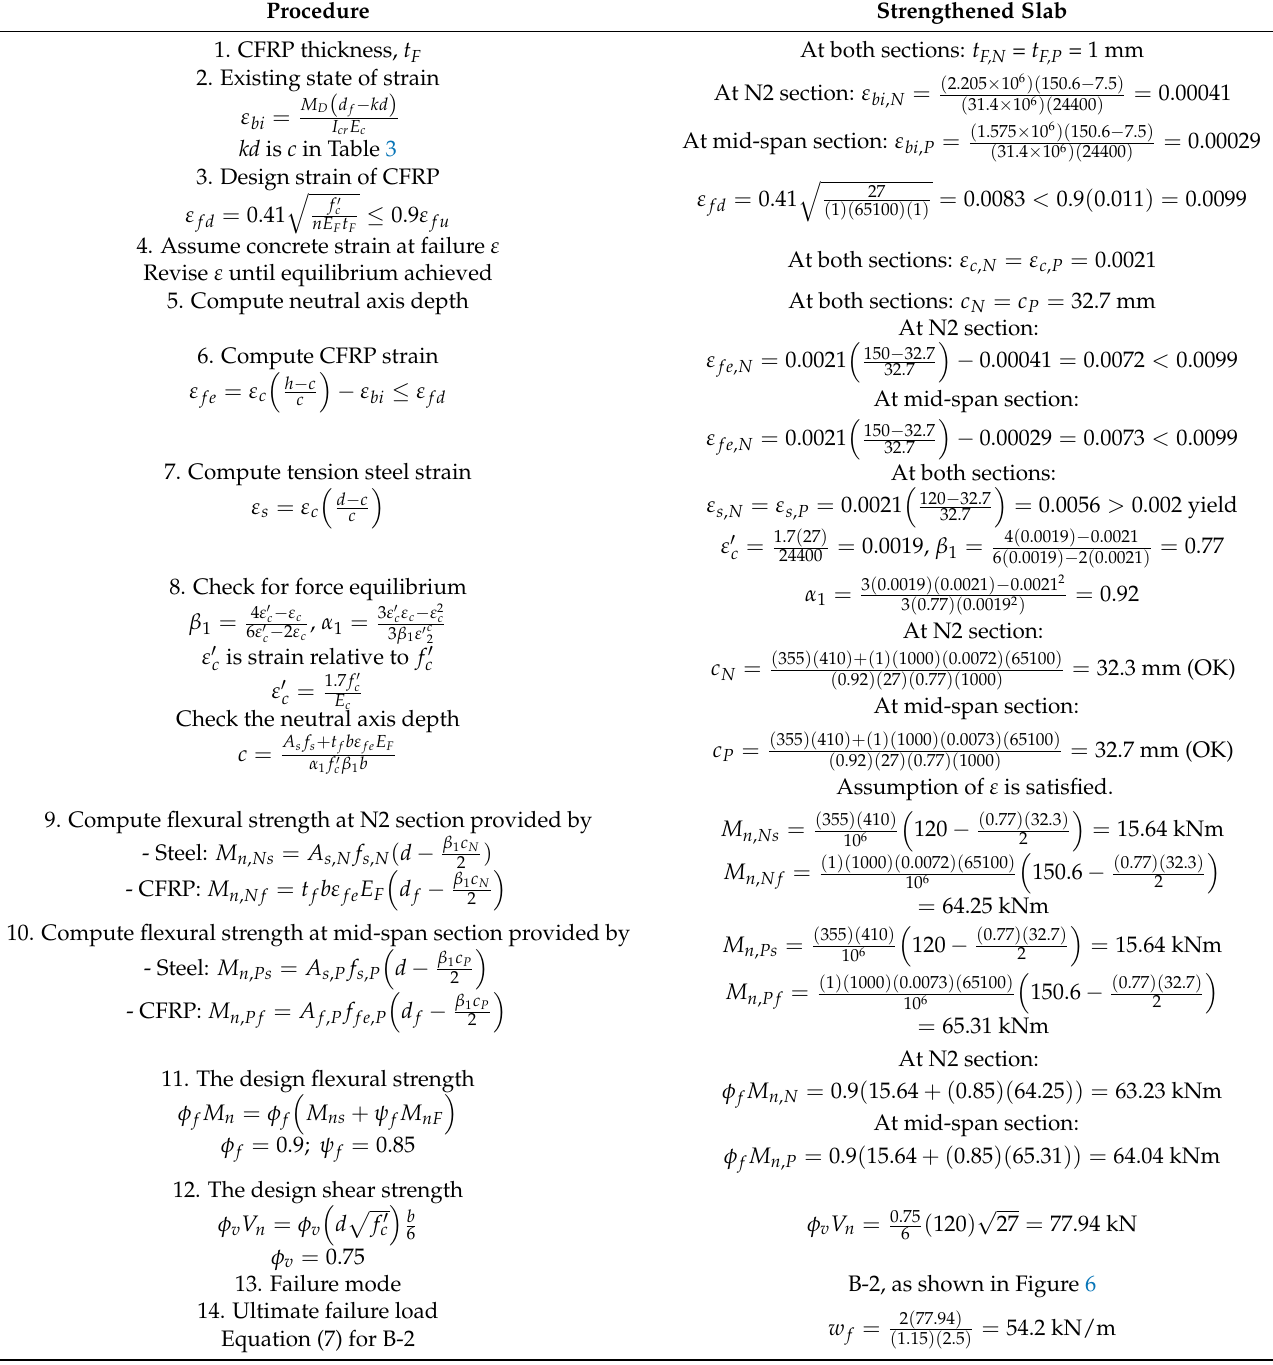
Table 4. Calculation of the strengthened